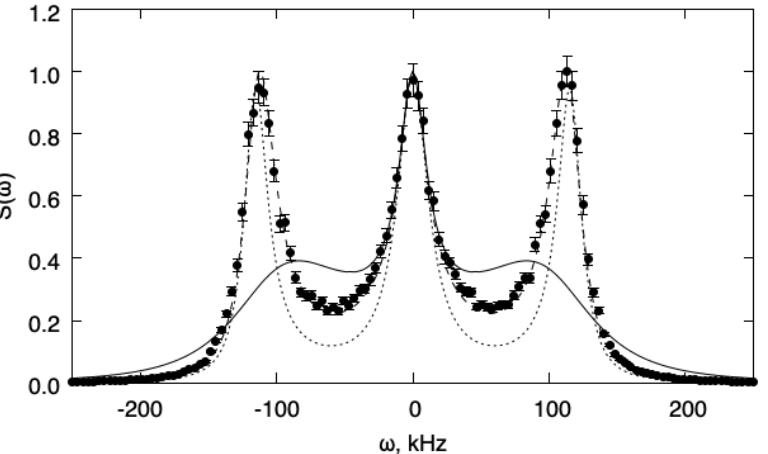
Figure 1. Fluctuation power spectra for the slow relaxation case ( p 0 = 0.01). The spectra are normalized to the unit maximum value. Full line: 1T model; dotted line: frozen; dashed line: 2T model; symbols: